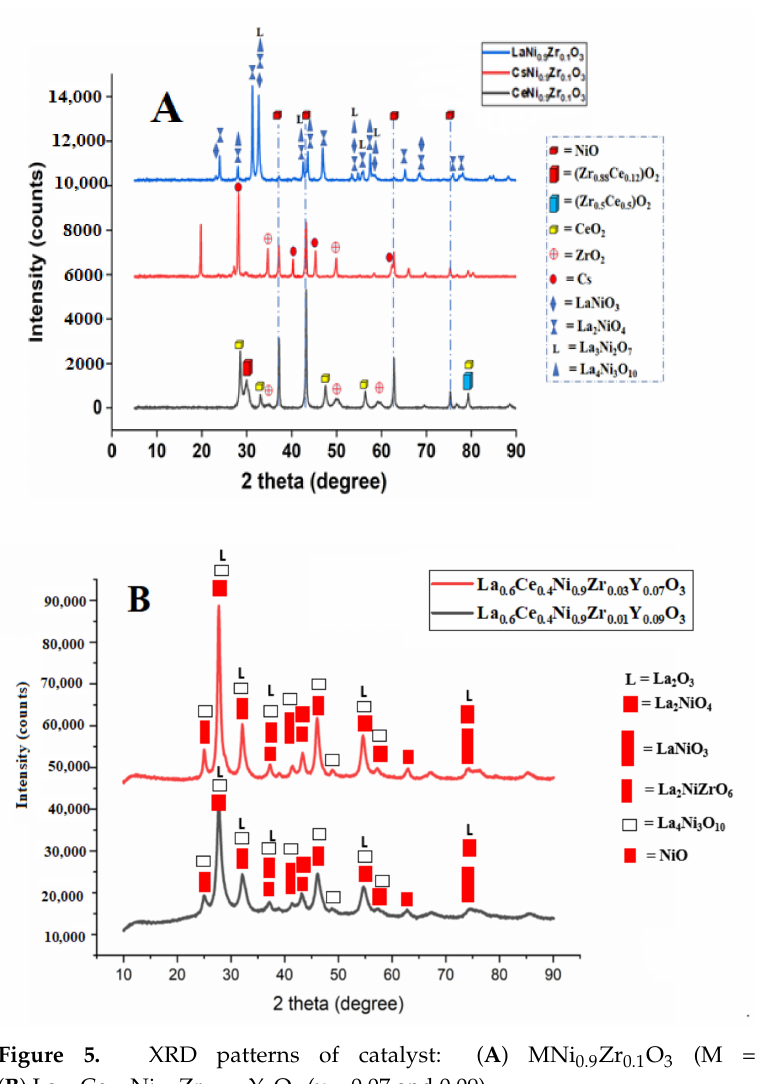
Figure 5. XRD patterns of catalyst: ( A ) MNi 0.9 Zr 0.1 O 3 (M = La, Ce, and Cs);